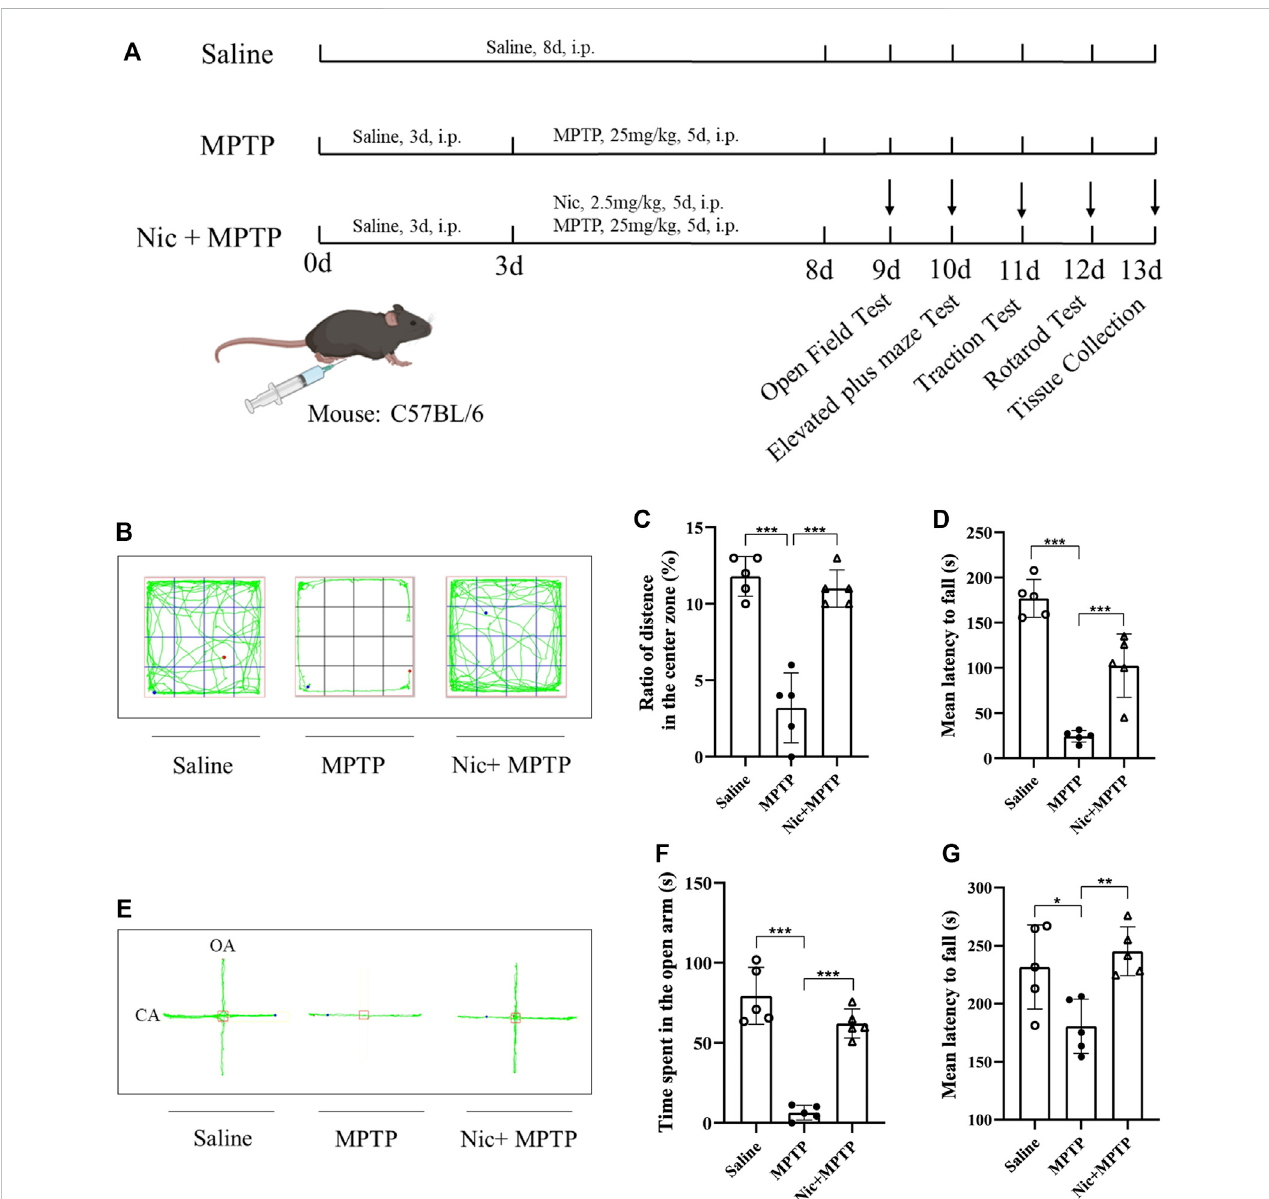
FIGURE 1 Effects of nicotine on locomotor performance and anxiety-like behavior in MPTP-treated mice. (A) Schematic diagram of the construction of a mouse model based on MPTP-induced neurological damage. (B) Representative locomotor paths of each group of mice in the open fi eld test. (C) Percentage of horizontalmotion distanceinthecentralregionin theopen fi eldtest. (D) Mean latency to falltime intractiontest. (E) Representative locomotorpathsof each group of mice in the elevated plus maze test. (F) Open arm horizontal movement time in elevated plus maze. (G) Mean latency to fall time in the rotarod test. Data are expressed as mean ± SEM from fi ve mice in each group. Signi fi cant differences were determined by an unpaired Student ’ s t-test and one-way ANOVA followed by Tukey ’ s multiple comparison post hoc test. * p < 0.05, ** p < 0.01, *** p <